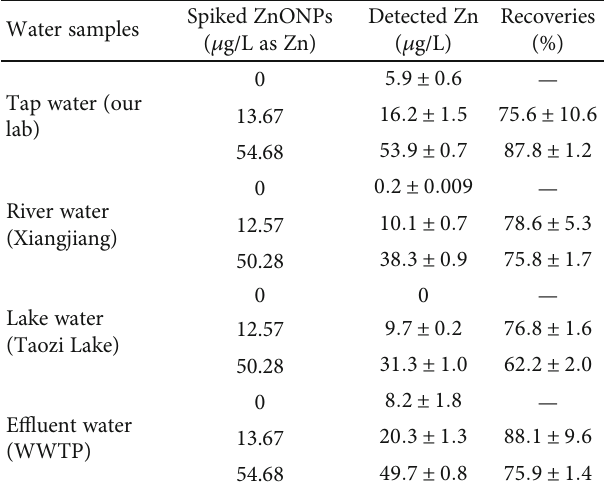
Table 5: Recoveries of ZnONP in environmental waters by the CPE-ICP-MS method ( n = 3